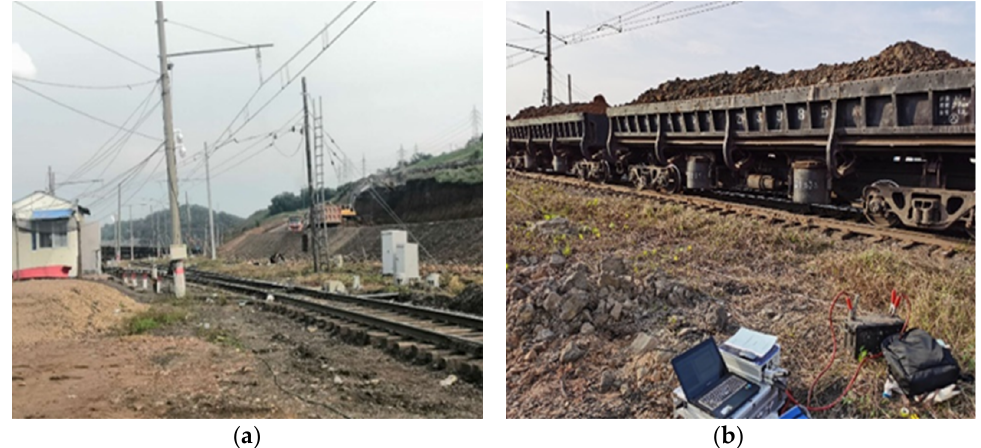
Figure 4. Field monitoring situation. ( a ) Location of the railway tracks; ( b ) monitoring site.